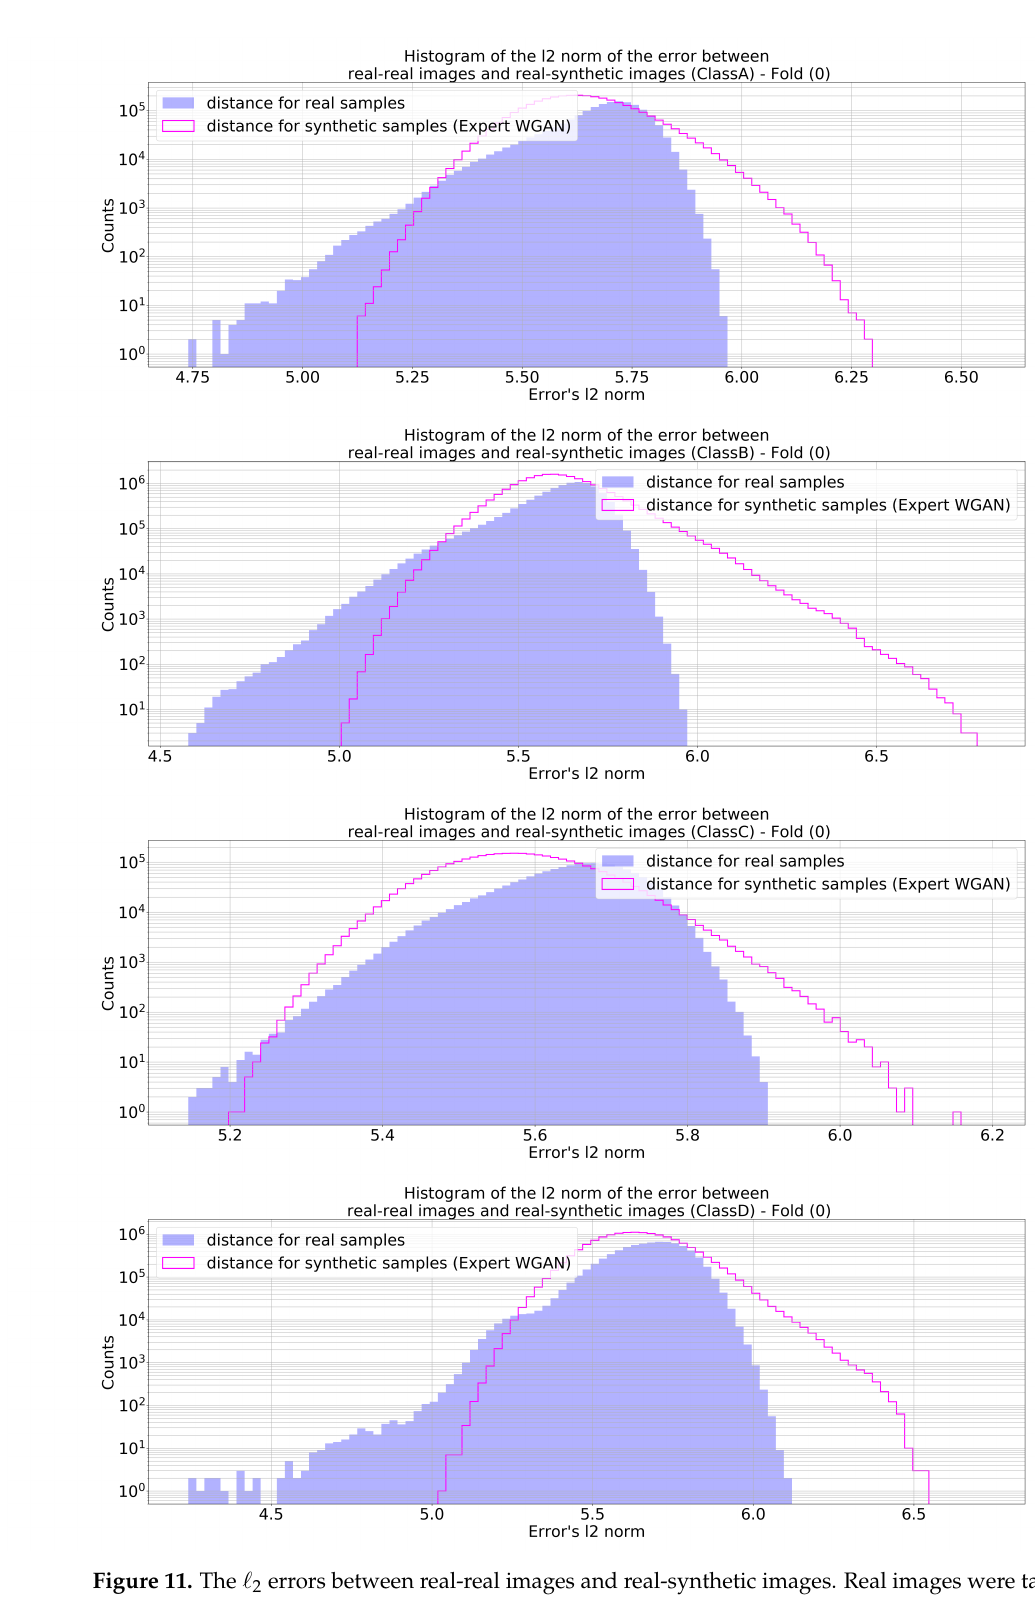
Figure 11. The (cid:96) 2 errors between real-real images and real-synthetic images. Real images were taken from the training set for the LORO-based